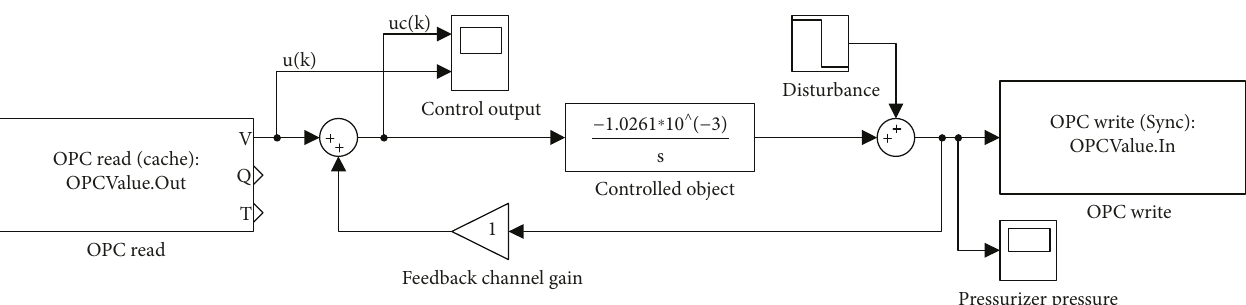
Figure 6: Simulation model based on pressurizer pressure adaptive predictive